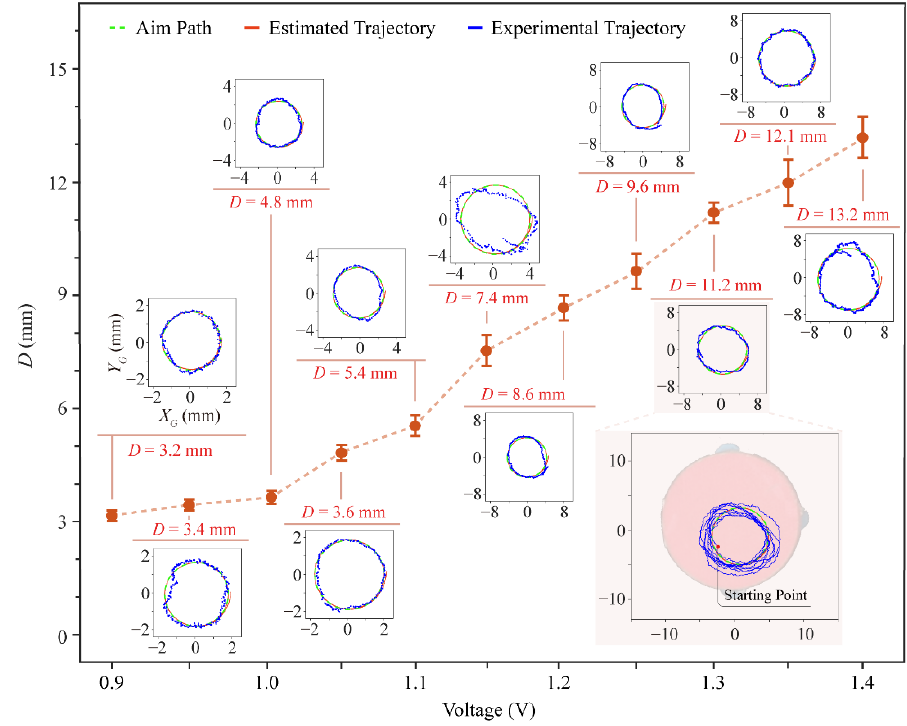
Figure 8. The diameter of the robot’s running trajectories on different voltages.